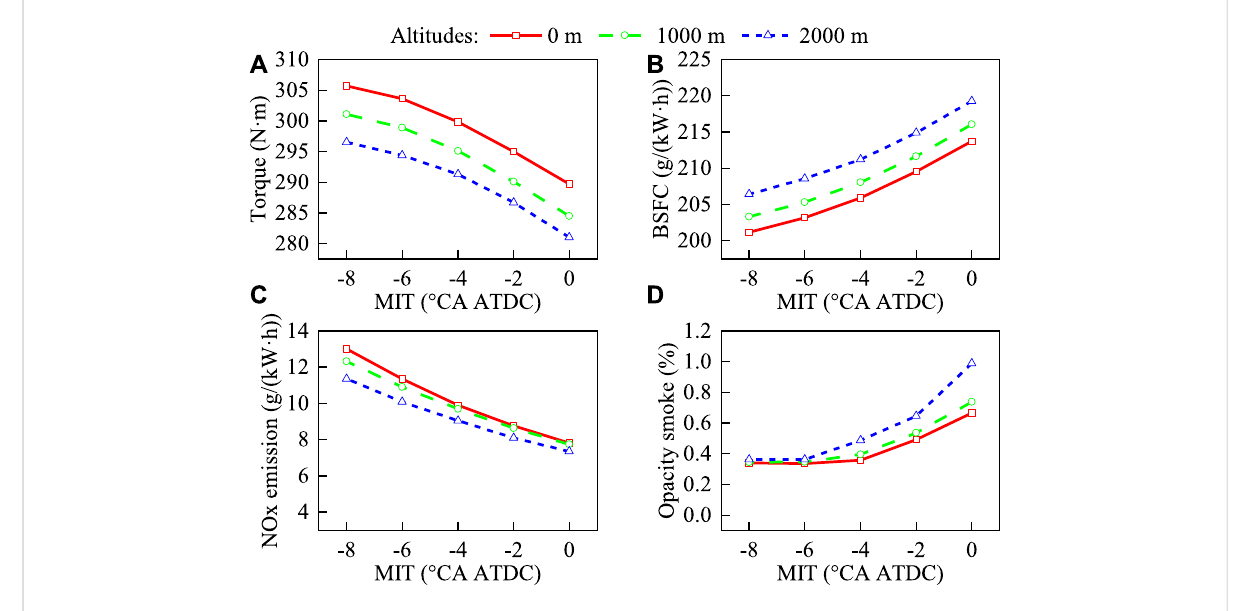
FIGURE 4 Impacts of MIT on engine performance and emissions, (A) torque, (B) BSFC, (C) NOx emission and (D) opacity